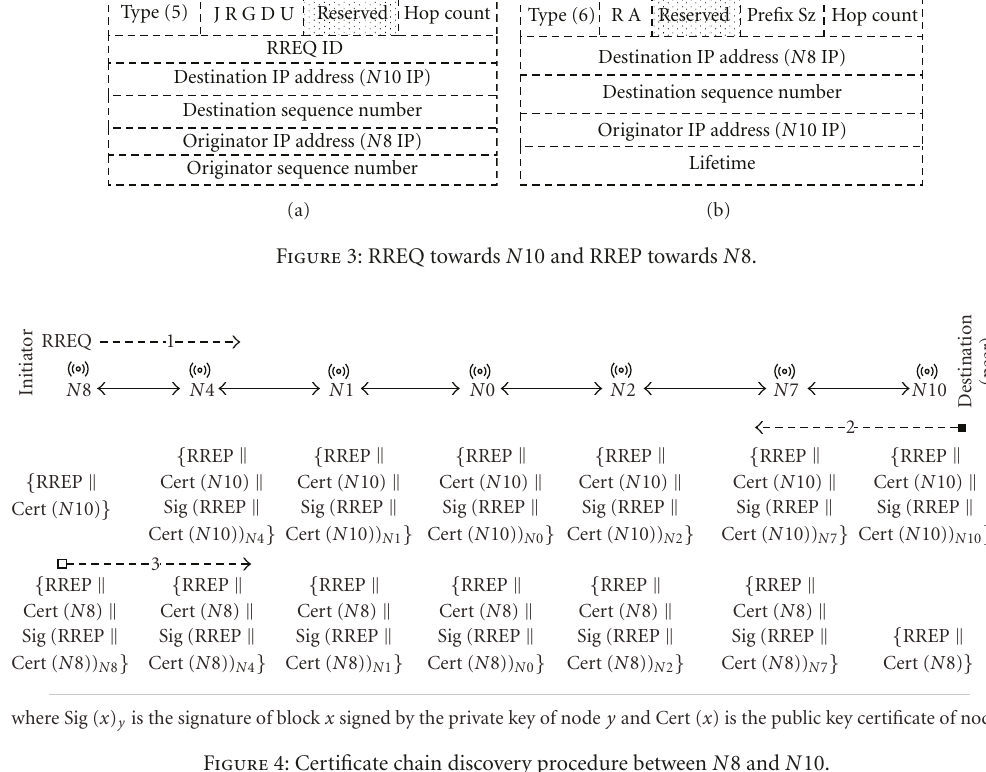
Figure 4: Certificate chain discovery procedure between N 8 and N